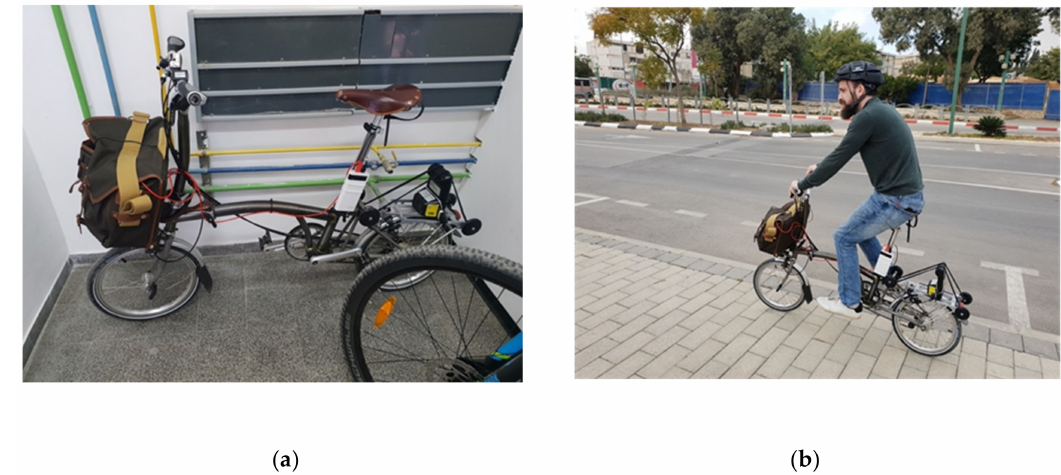
Figure 3. Brompton bicycles used for mobile measurements: ( a ) equipped with the COTS sensors and GPS and ( b ) in the field